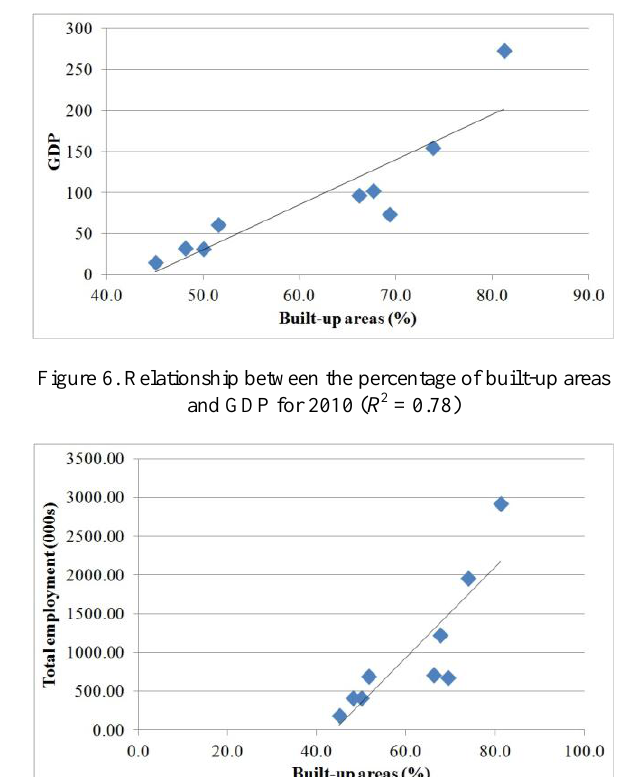
Figure 8. Relationship between the percentage of built-up areas and population for 2010 ( R 2 = 0.71)